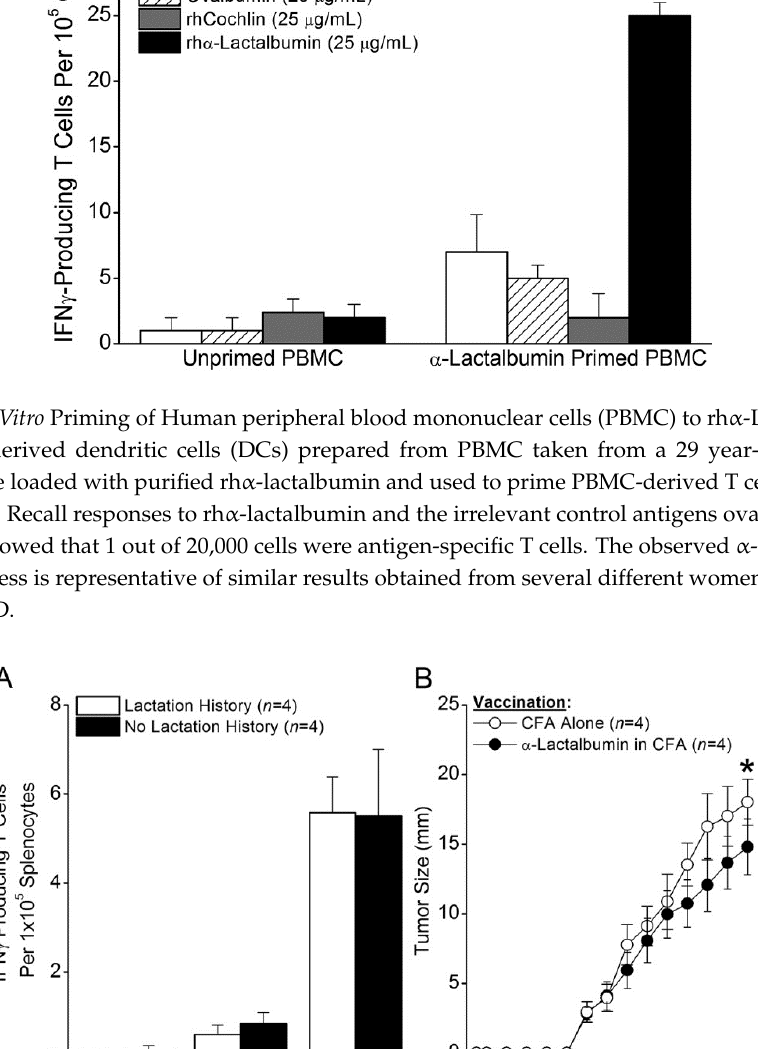
Figure 1. In Vitro Priming of Human peripheral blood mononuclear cells ( PBMC) to rhα-Lactalbumin. Monocyte derived dendritic cells ( DCs) prepared from PBMC taken from a 29 year-old healthy woman were loaded with purified rh  -lactalbumin and used to prime PBMC-derived T cells from the same donor. Recall responses to rh  -lactalbumin and the irrelevant control antigens ovalbumin and rhcochlin showed that 1 out of 20,000 cells were antigen-specific T cells. The observed  -lactalbumin responsiveness is representative of similar results obtained from several different women. Error bars indicate ±SD.